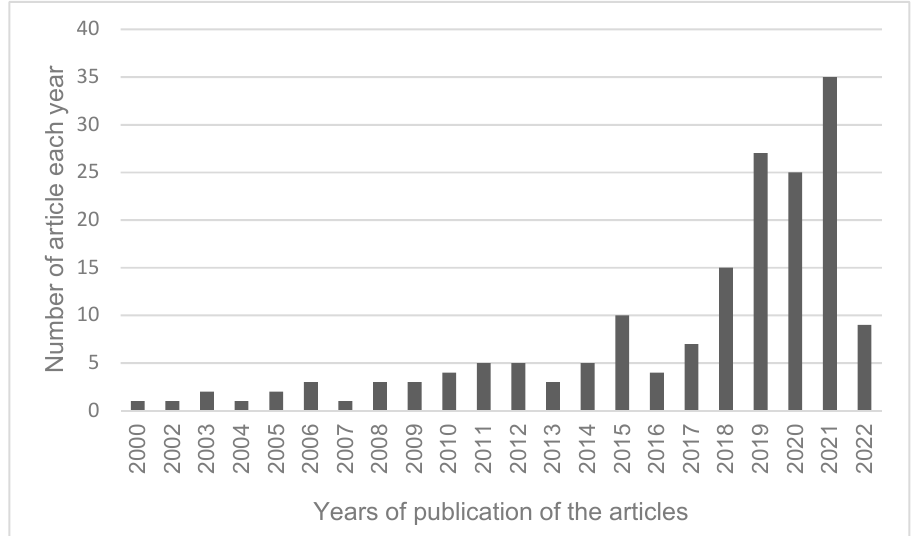
Figure 2. Distribution of the number of articles used per year.